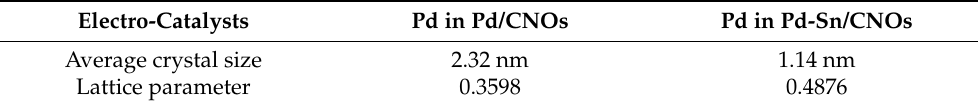
Table 1. Average crystal sizes and lattice parameters of Pd in the synthesized nanomaterials.